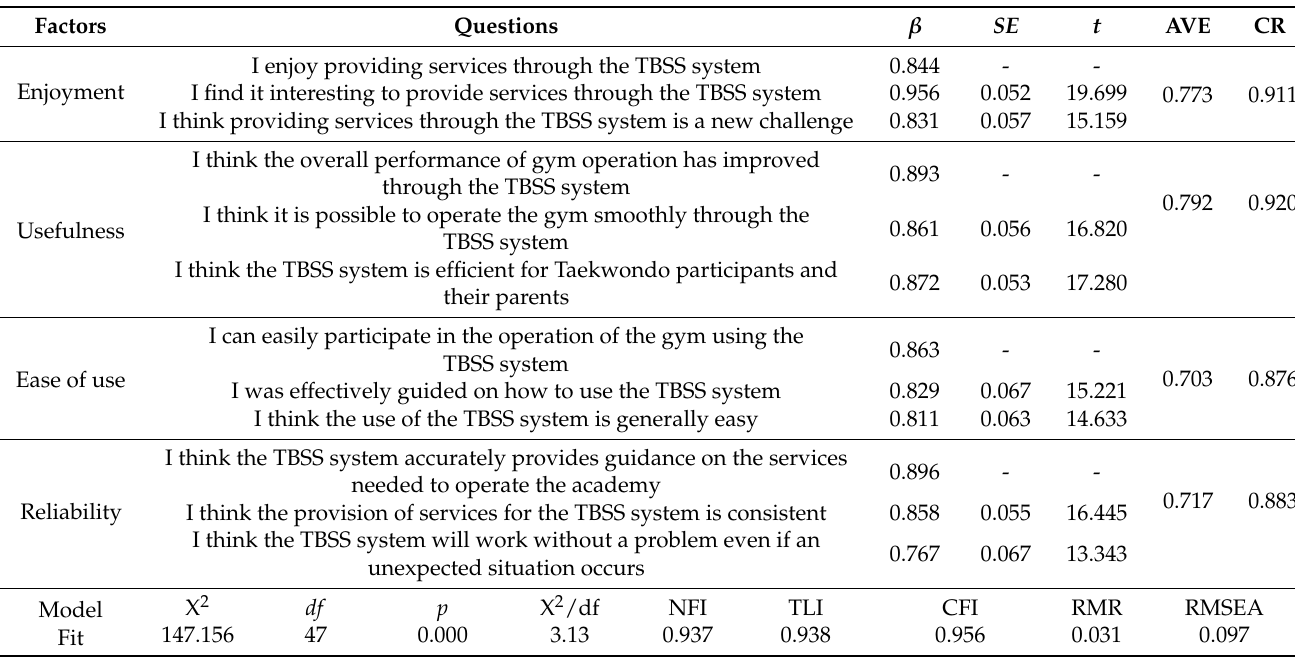
Table 2. Results of CFA on TBSS characteristics.